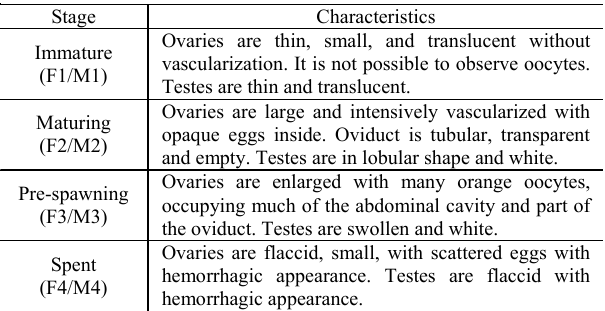
Table 1. Macroscopic description of gonadal